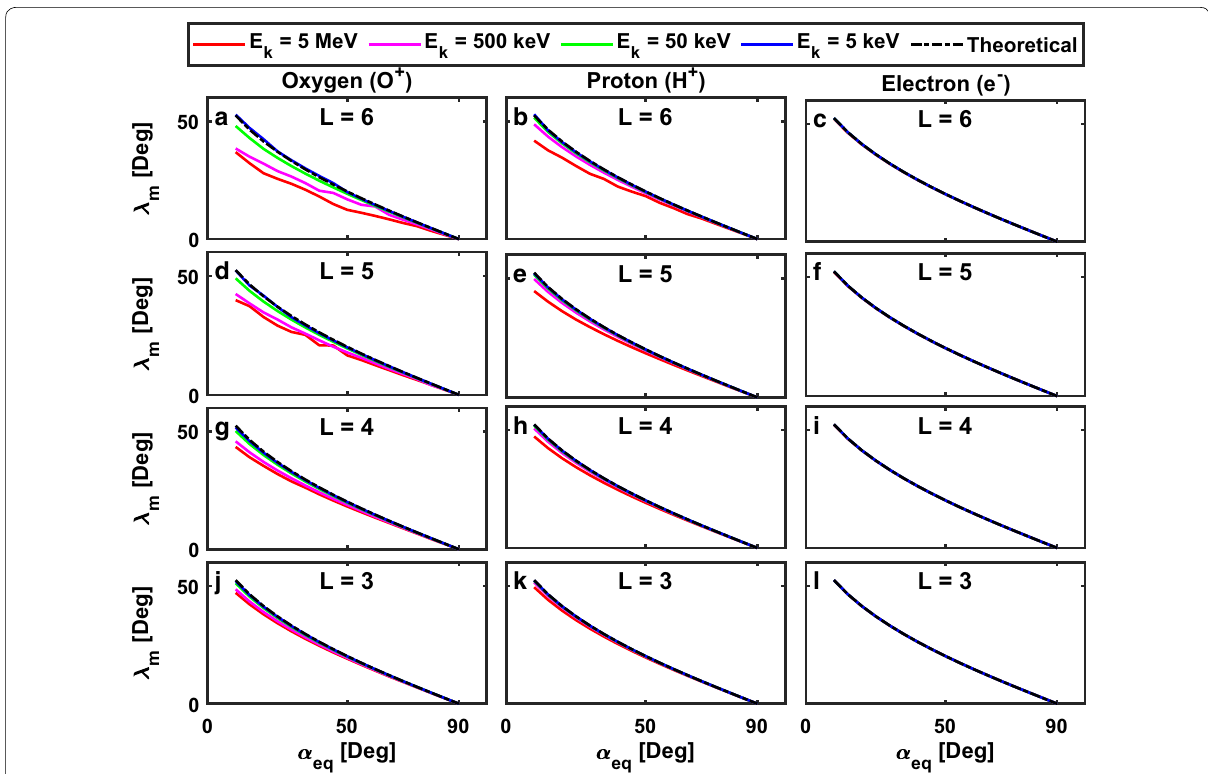
Fig. 6 The magnetic mirror point latitude as a function of the equatorial pitch angle of the particle at different L-shells. a , d , g , j are for oxygen ions, b , e , h , k are for protons, and c , f , i , l are for electrons. The dashed black line is obtained from the theoretical Eq. (6) and the solid lines correspond to the simulation results of (cid:31) m for fixed ψ = 90 ◦ , fixed L-shell and different energy ( E k = 5MeV , 500 keV, 50 keV,